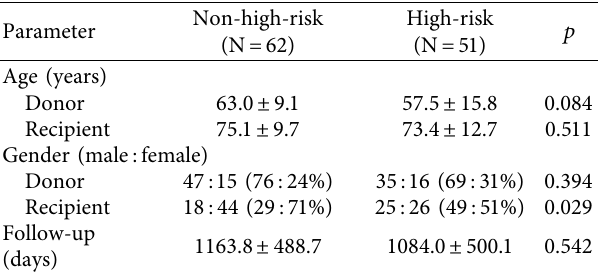
Table 2: Baseline characteristics comparison between non-high- risk and high-risk patients.